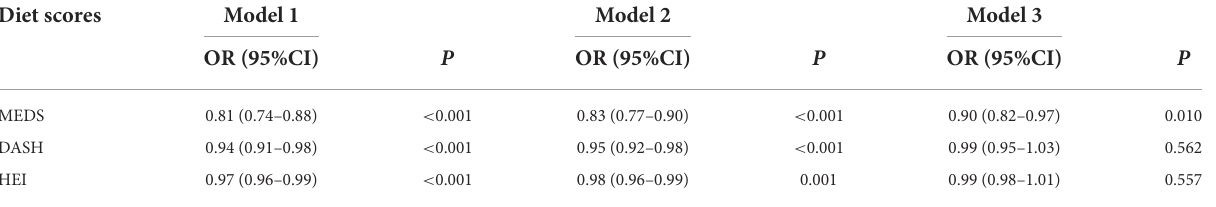
TABLE 2 Association analysis of MEDS, DASH, and HEI 2015 with depression.